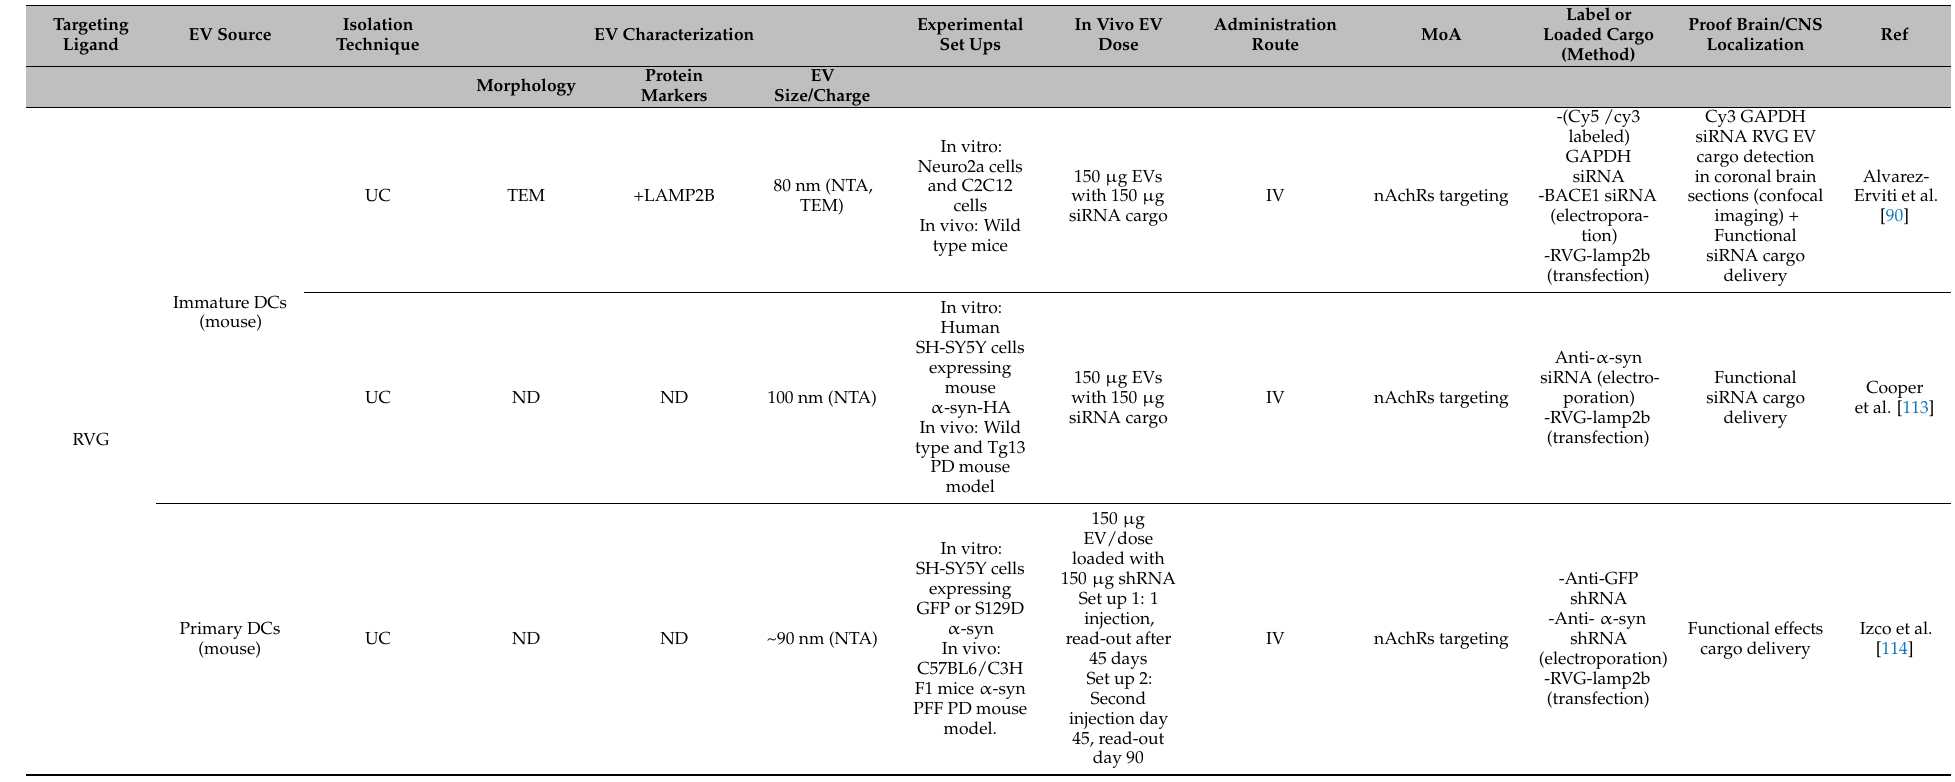
Table 2. Overview modified EVs applied for enriched brain delivery. This table summarizes the experimental set ups and read-outs of the different modified or targeted EVs in brain delivery or brain disease EV treatment studies. Furthermore, information about the EV characterization based on the Minimal Information for Studies of EVs (MISEV) guidelines is included [3]. The “+” symbol in the protein marker column indicates the assessment of typical EV markers whereas the “-” symbol indicates the assessment of non-EV markers.